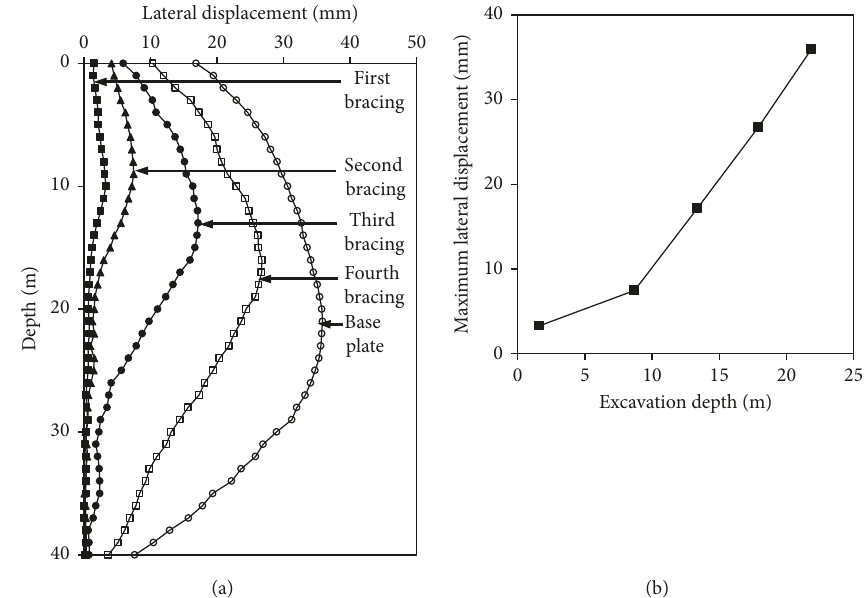
Figure 8: Lateral displacement for monitoring point CX9. (a) Curves of lateral displacement versus depth. (b) Curve of maximum lateral displacement versus excavation depth.